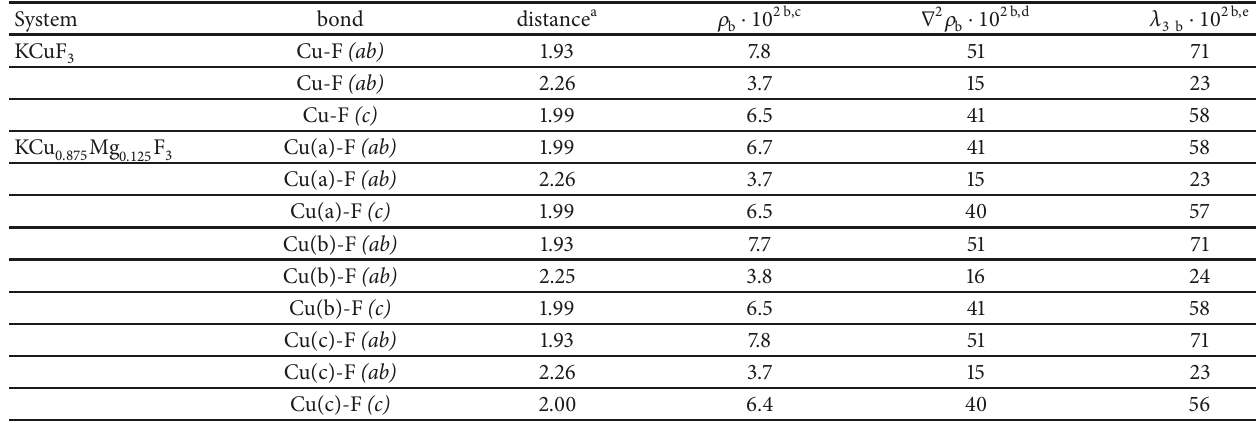
Table 2: Cu-F bonding properties in the AF1 phase of pure and Mg-doped KCuF 3 . System